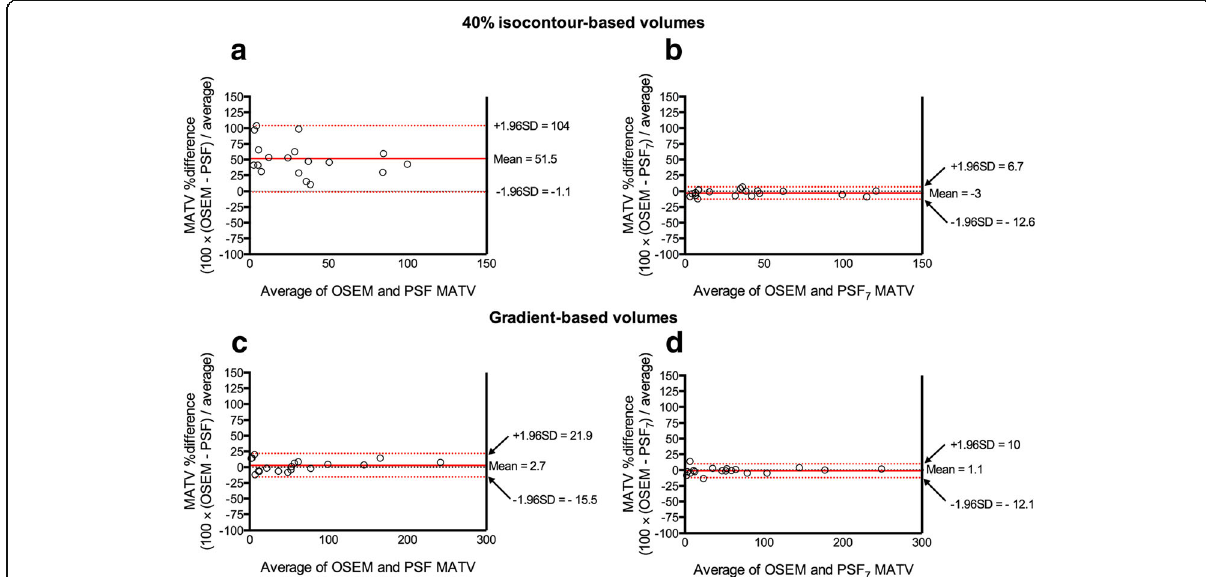
Fig. 4 Comparison of MATVs from PSF images optimised for diagnostic potential and EARL-compliant PSF 7 images (observer 1). Relationships between MATVs extracted from OSEM reconstructions and PSF or PSF 7 reconstructions, for the 40% isocontour-based methods ( a , b ) and gradient-based methods ( c , d ), assessed using Bland – Altman